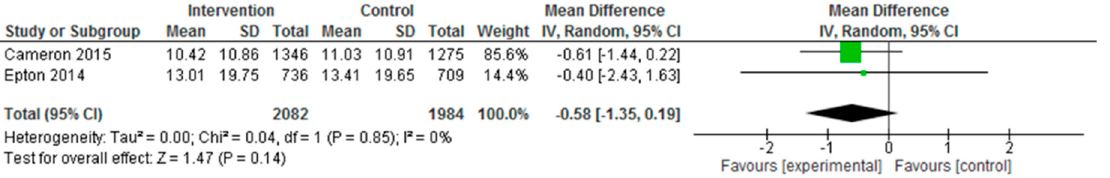
Figure 2. Meta-analysis of volume consumed in units.